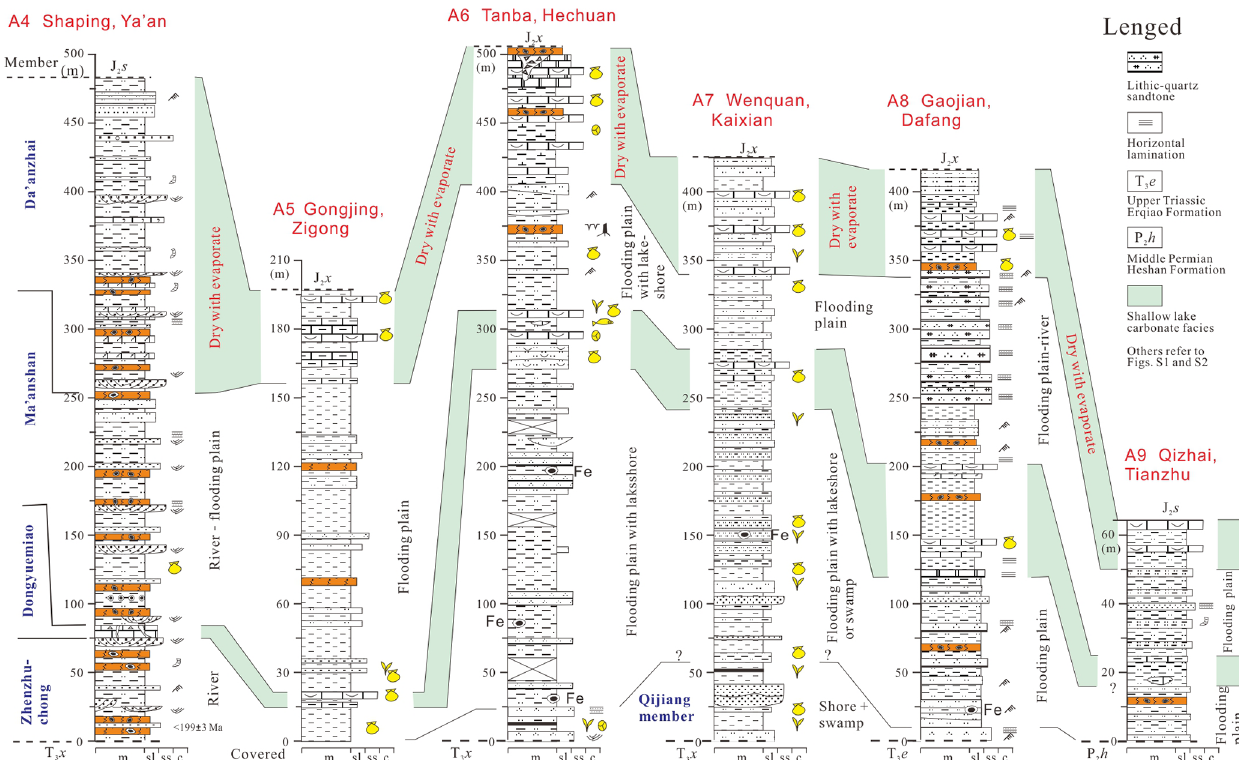
Figure 7. Stratigraphic correlation and depositional environment interpretation of the Lower Jurassic in the GSB. Data of each section refer to Fig. 1. Note, two lacustrine transgressive cycles are marked by correlative pale green